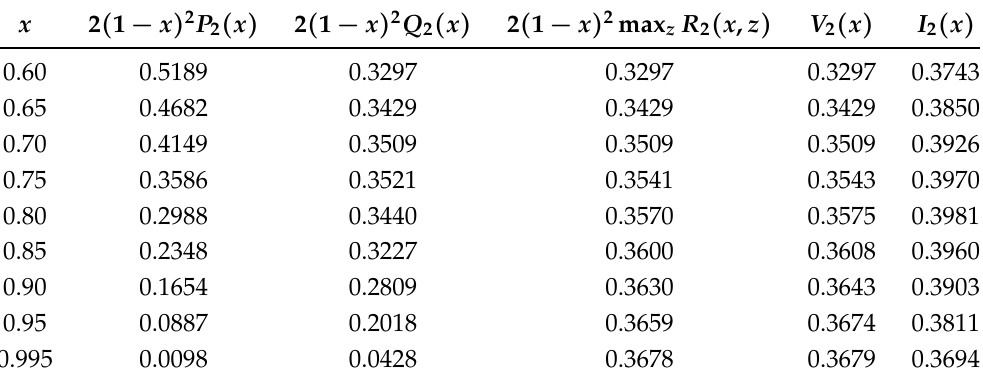
Table 3. Winning probability and bounds for k = 2.